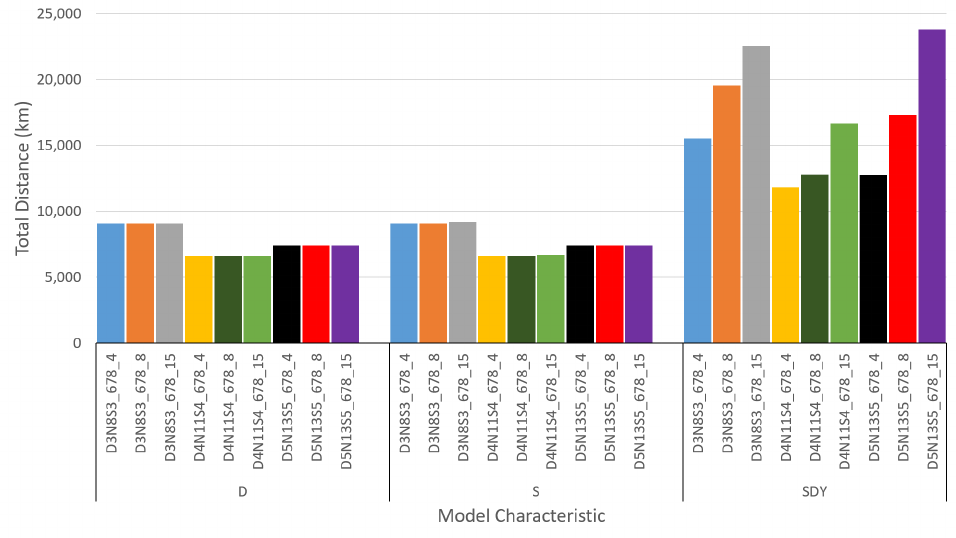
Figure A14. Total Distance Travelled for Maximum Road Capacity Setting ( 6,7,8 ) in Online and Offline Computation for all Instances grouped by Model